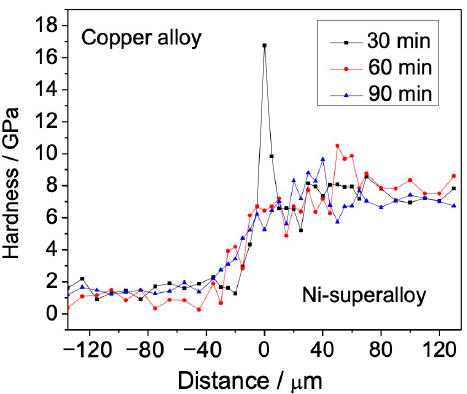
Figure 8. Effect of bonding time on the hardness distributions of samples bonded at 1030 °C.